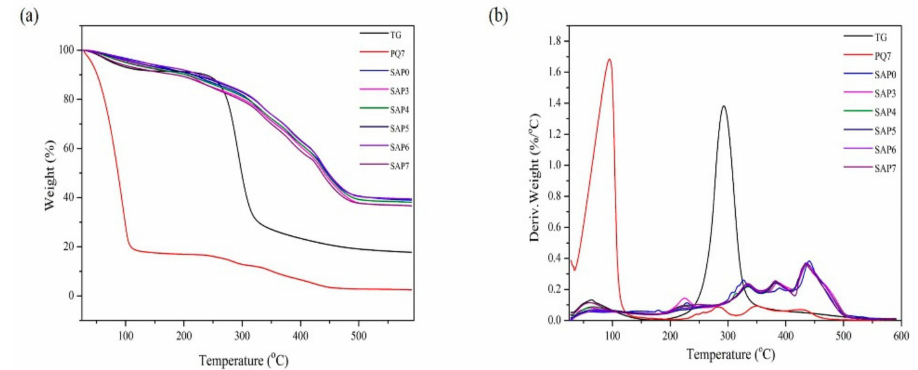
Figure 6. TGA curves ( a ) and DTG curves ( b ) of TG, PQ7 and the